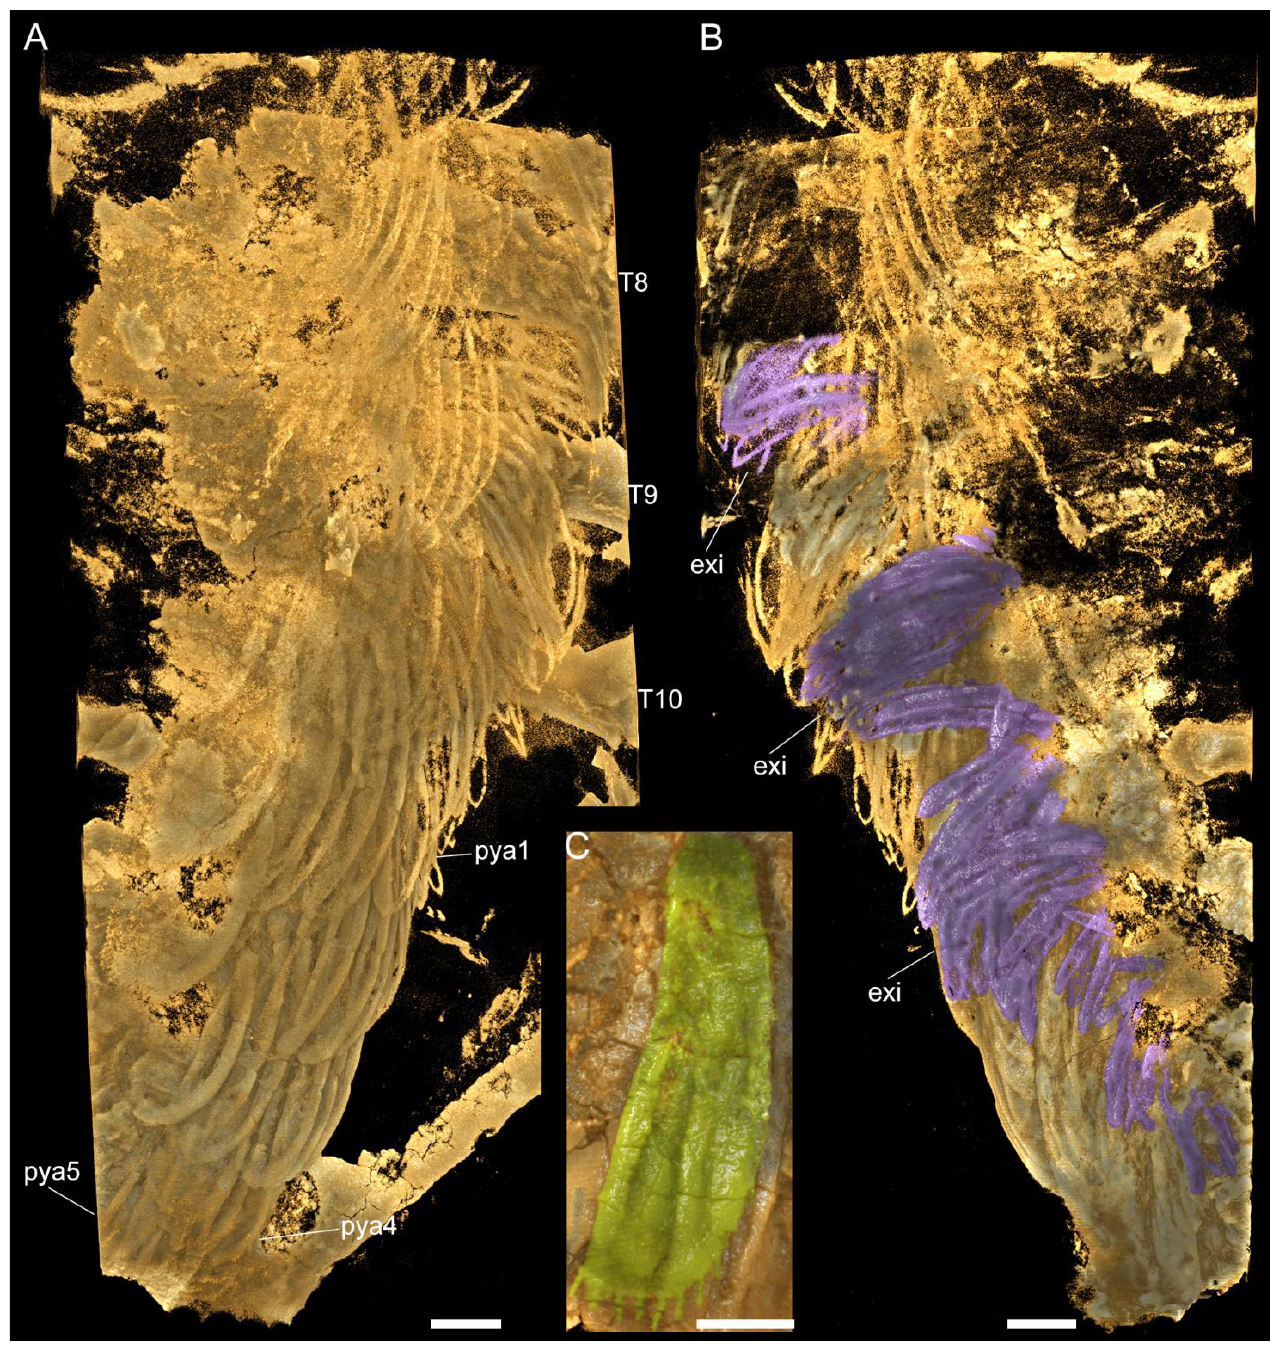
Figure A2. Images rendered from 3D tomographic models of Retifacies abnormalis (YKLP 11430, Figure 1E) showing left posterior thoracic appendages and pygidial appendages. ( A ) Ventral view. ( B ) Dorsal view with pygidium and thoracic tergites removed, showing the exites (false-coloured in purple). ( C ) the distal lamella of fifth pygidial appendage showing marginal spines. Scale bars: 1mm in ( A , B ), 0.5 mm in ( C ).